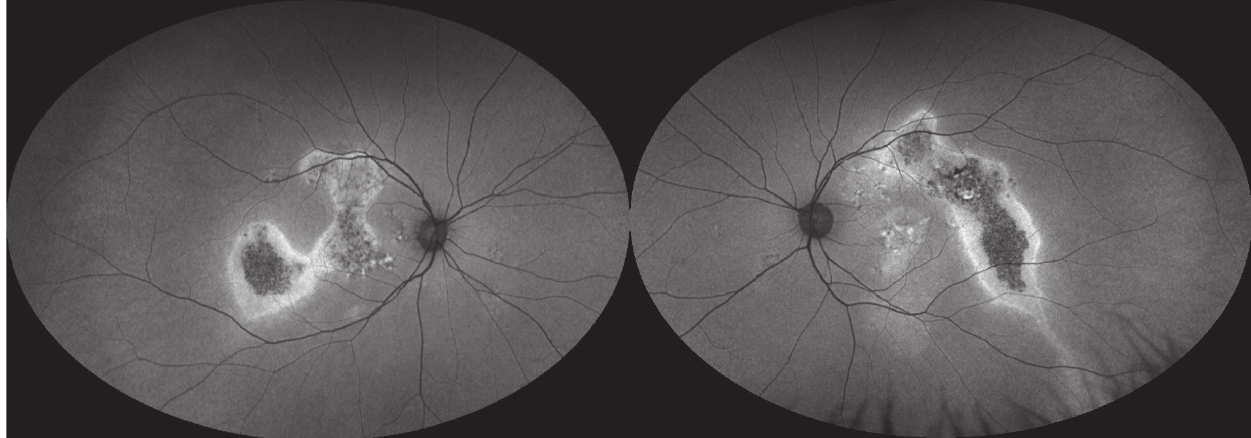
Figure 5. Green light ultrawide field fundus autofluorescence (UWF-FAF) (Optos) of the fundi of a patient with chronic central serous chorioretinopathy (CSCR). Left: Right eye demonstrating patches of mottled hyperautofluorescence (hyper-AF) and hypoautofluorescence (hypo-AF) indicating variable retinal pigment epithelium (RPE) and outer retinal atrophy. The surrounding hyper-AF indicates outer retinal thinning with intact RPE. Right: Left eye demonstrating similar findings to the right eye, with more prominent gravitational pattern, which is diagnostic.